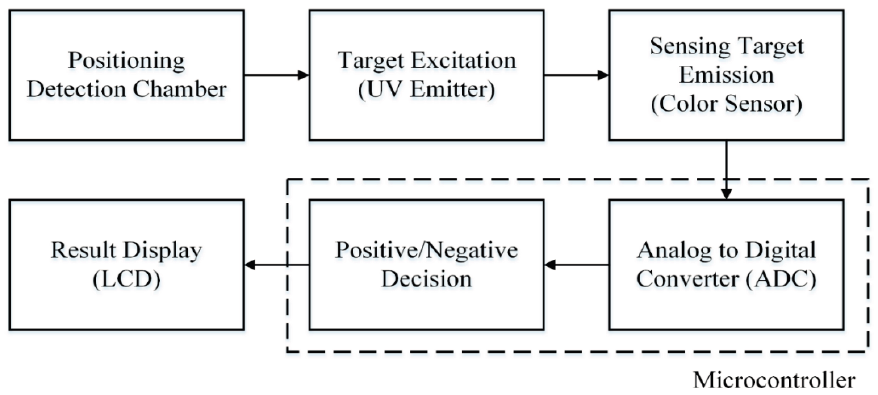
Figure 2. Block diagram of the endpoint detection